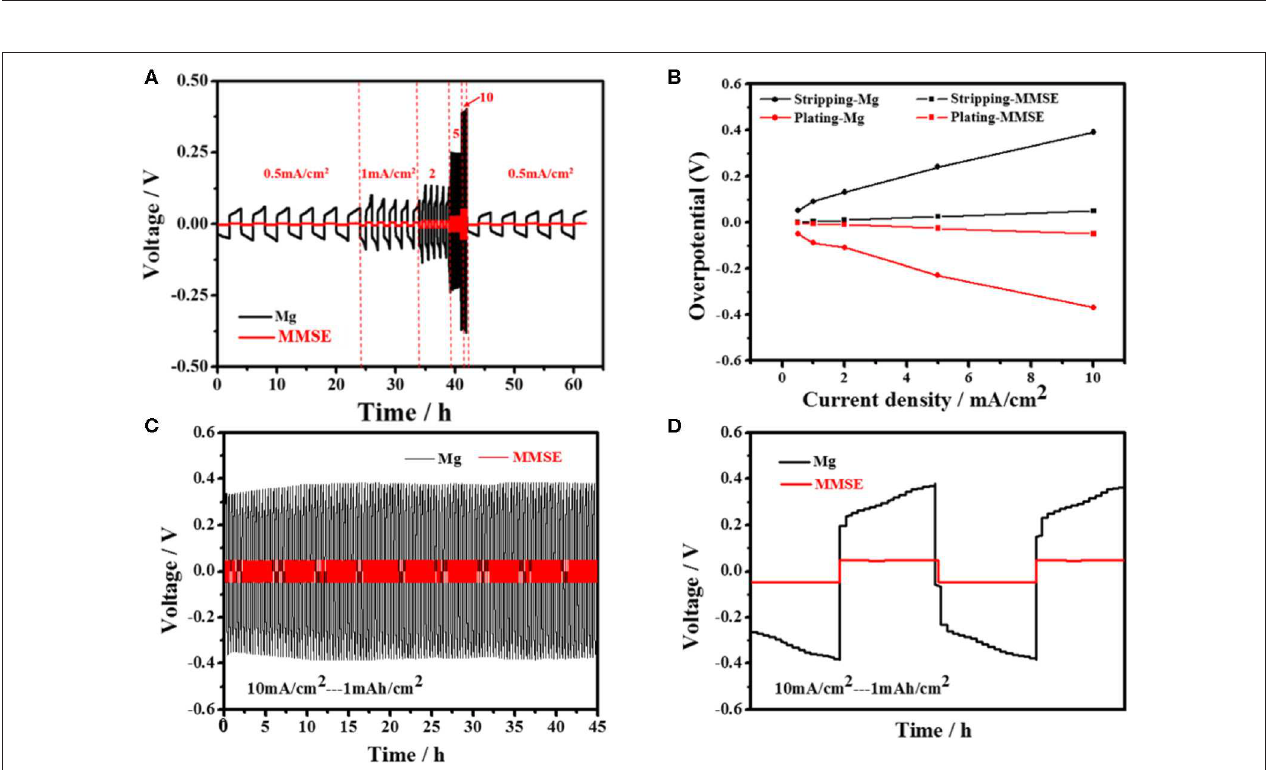
FIGURE 3 | (A) Voltage profile of Mg symmetric cell (black) and that of MMSE symmetric cell (red) at different rate various from 0.5 to 10 mA/cm 2 . (B) Overpotentials for plating and stripping of Mg electrode and MMSE during cycling. (C) The voltage profiles of Mg symmetric cells (black) and MMSE symmetric cells (red) at the current densities of 10 mA/cm 2 and (D) magnified Mg plating/stripping profiles.